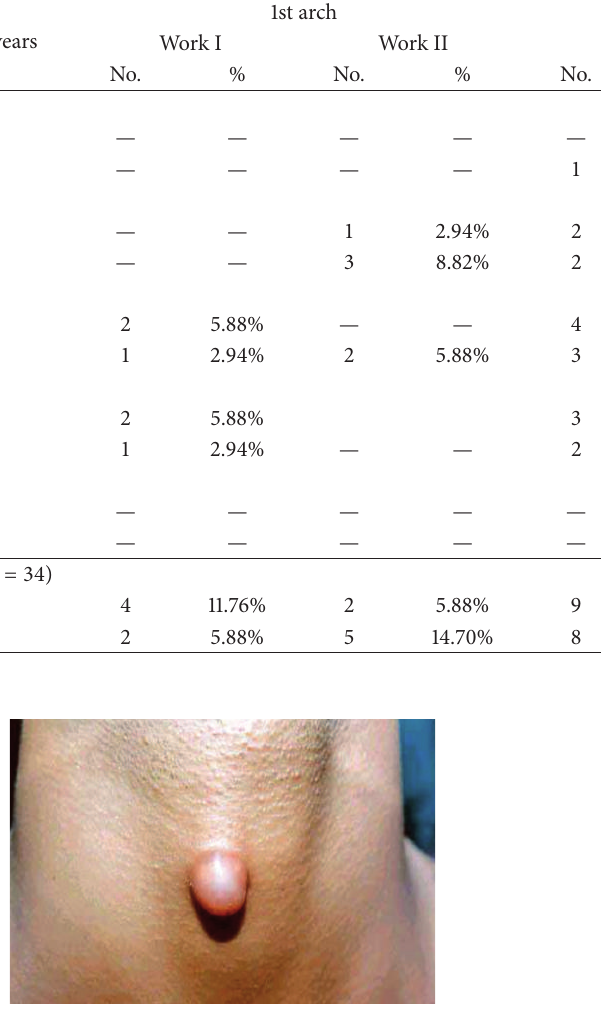
Figure 6: Bilateral branchial